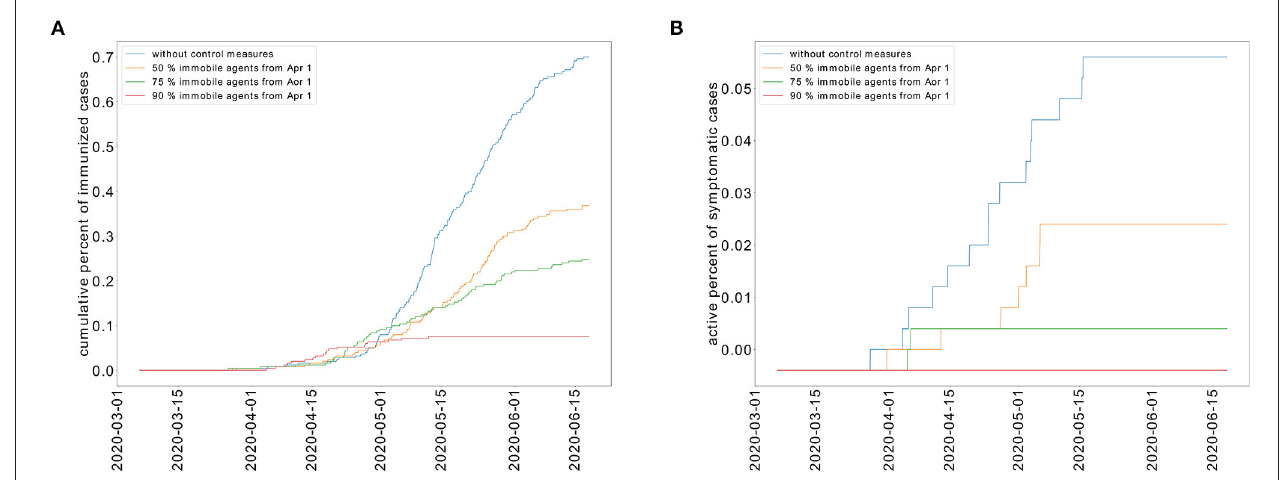
FIGURE 8 | Cumulative percent of recovered individuals (A) and deceased patients (B) for different levels of restricted